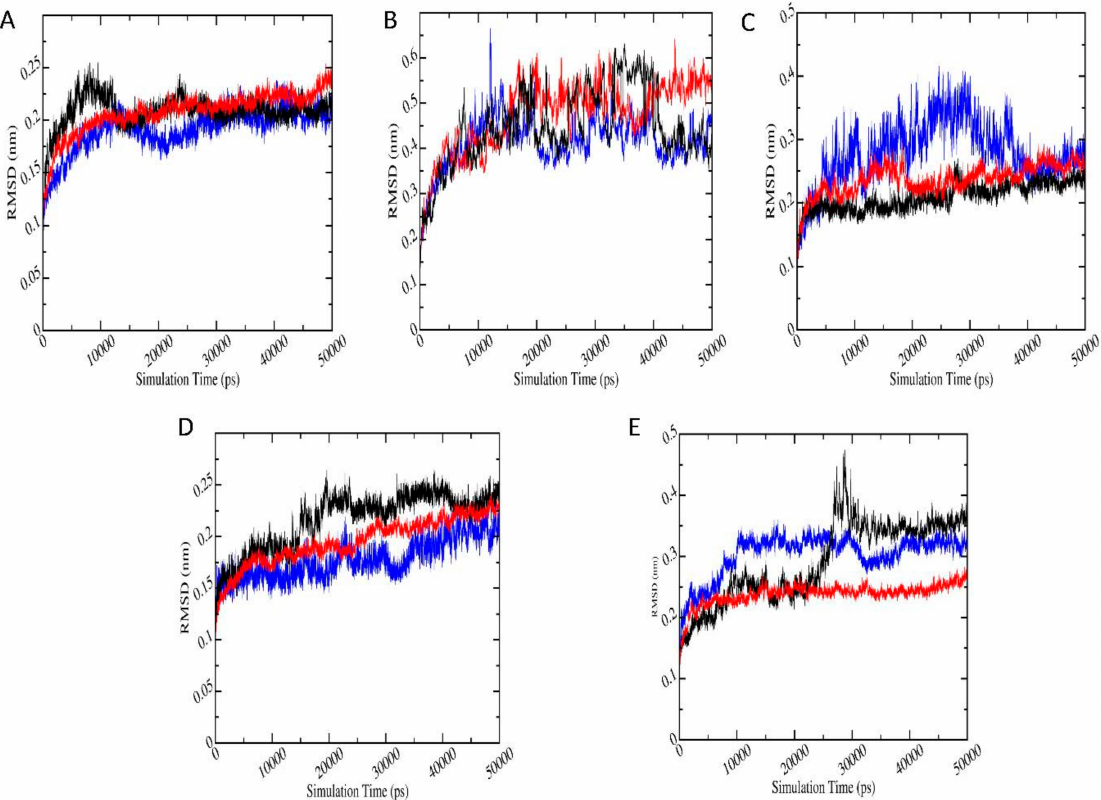
Figure 5. Plot root mean square deviation (RMSD) (nm) versus simulation time (pS), where black, red, and blue color plots represent the parent pesticide, metabolite, and apo-enzyme, respectively. ( A – E ) indicate AChE-FM/FMS, AMPK-FN/FNS, ASK1-FM/FMS, GST-IM/6-CIPHD, and PKC-IM/6-CIPHD complexes,